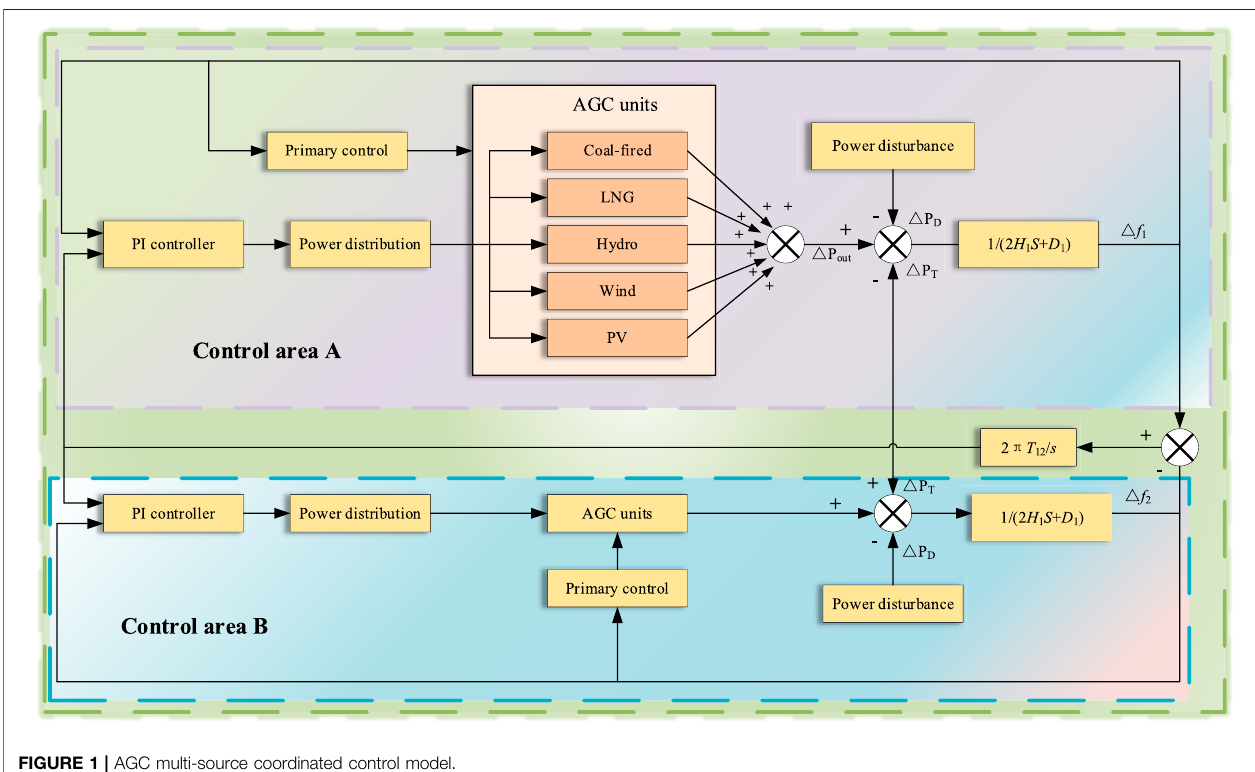
FIGURE 1 | AGC multi-source coordinated control model.